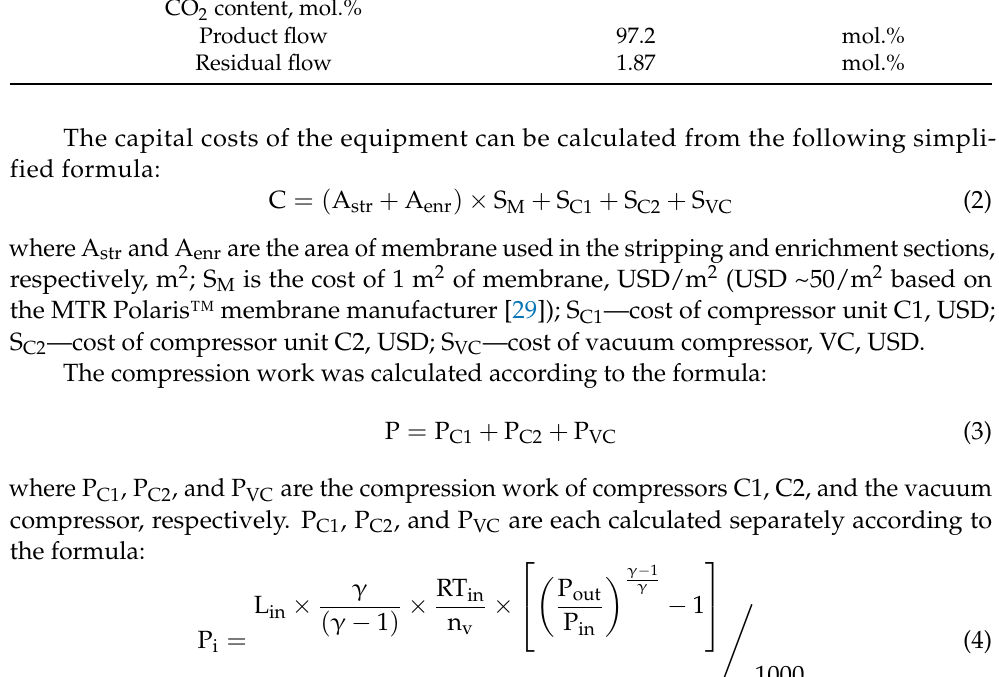
Table 2. Key process parameters of the CO 2 processing in the membrane cascade during its capture from CHPP flue gases. Parameter Value Units Pressure in the feed side, MPa 0.15 MPa Pressure in the permeate side, MPa 0.02 MPa Membrane area, m 2 Stripping section 52,780 m 2 Enrichment section 4500 m 2 Membrane permeance, GPU 1000 GPU Membrane selectivity for CO 2 /N 2 50 CO 2 content, mol.% Product flow 97.2 mol.% Residual flow 1.87